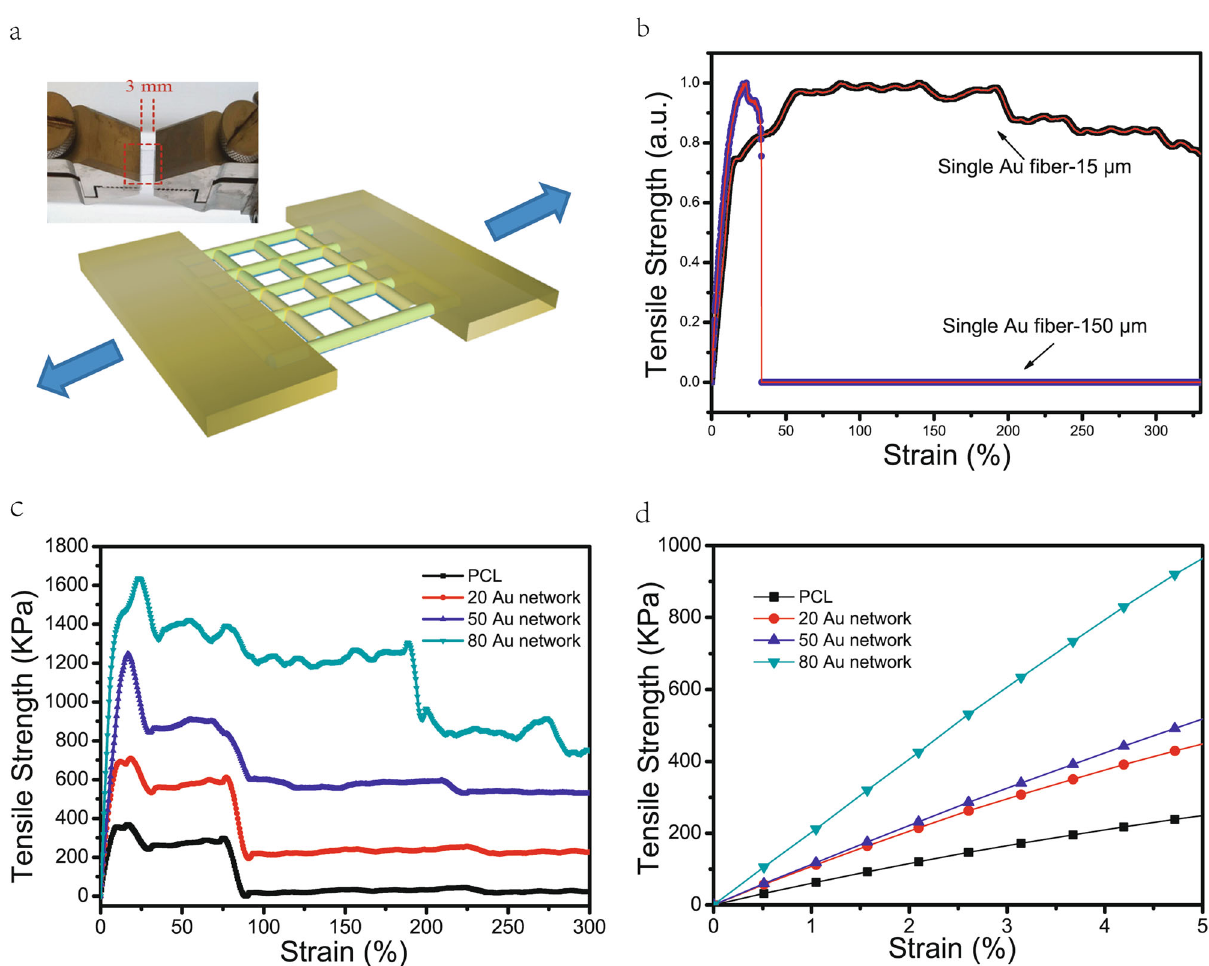
Fig. 4 a Schematic of the mechanical device. Inset shows a Photograph of Au networks before stretching. b Tensile strength single Au micro fi ber with different diameter of 15 or 150 μ m. c , d The tensile stress – strain curves of PCL networks without coating and coated with 20, 50, and 80 nm Au